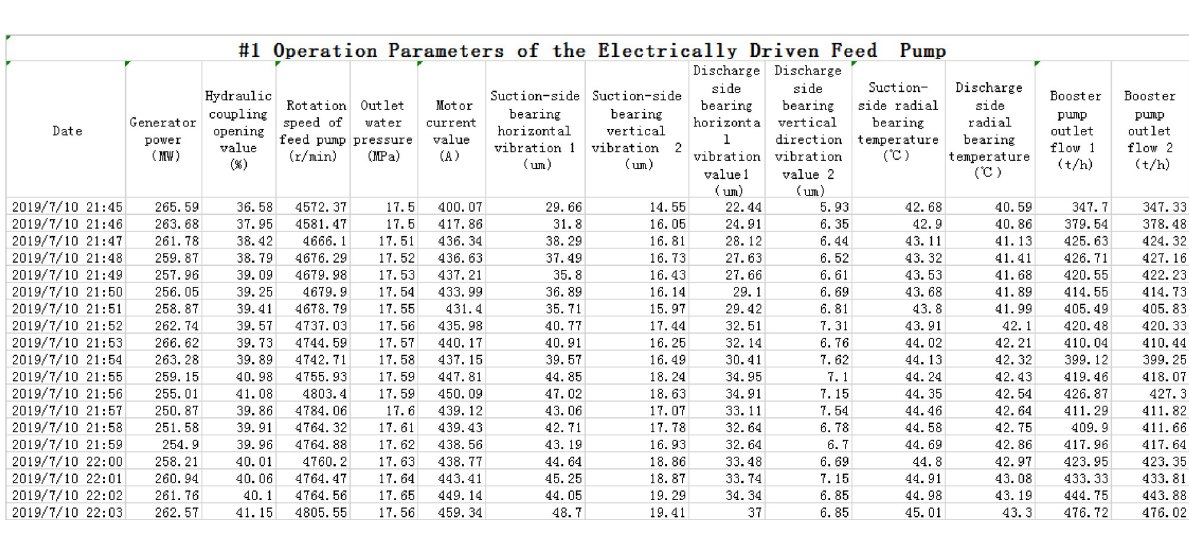
Fig 7. Collected field data